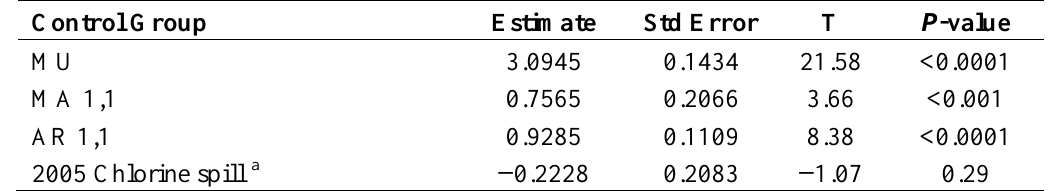
Table 3. ARMA (1,1) model parameter characteristics for Control Group: SC Medicaid Beneficiaries,